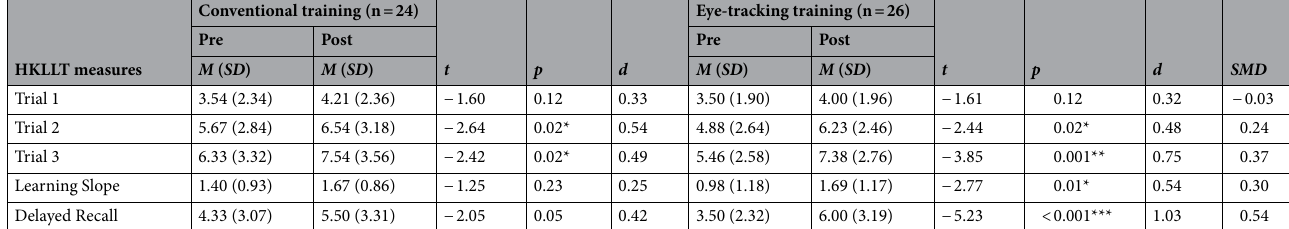
Table 2. Comparison of the number of words recalled at three learning trials and 10-min delayed recall trial, and the learning slope of the Hong Kong List Learning Test (HKLLT) before and after training between two groups. SMD = Standardized mean difference, which is computed as [(M_post_experimental − M_pre_ experimental)/((SD_post_experimental + SD_pre_experimental)/2)] − [(M_post_control − M_pre_control)/